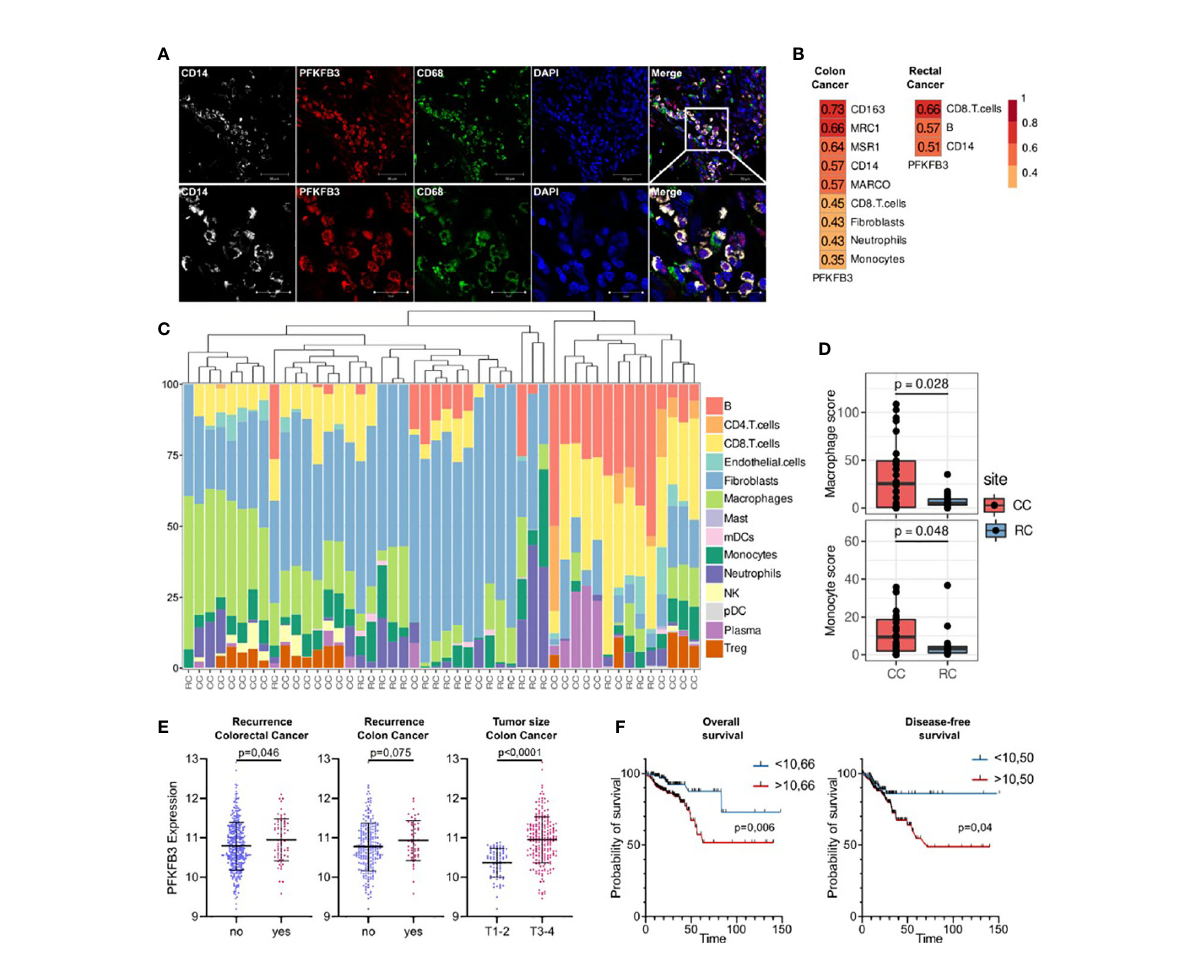
FIGURE 6 An activator of glycolysis PFKFB3 is overexpressed in colon cancer and is indicative for higher risk of tumor relapse in colon cancer but not rectal cancer. (A) , С olon cancer tissue is massively in fi ltrated by PFKFB3-positive monocytes. IF/confocal microscopy analysis was performed for 10 colon tumor tissues. The in fi ltration of CD14+CD68+PFKFB3+ cells was found in all samples. Representative image is given from one patient. Scale bar corresponds to 50 µm in main image and 20 µm in zoom image. (B) , Spearman correlation coef fi cients between PFKFB3 expression, M2 macrophage gene expressions and predicted cell abundance scores, FDR<0.05. (C) , Predicted cell composition of CD45+ AOIs and hierarchical clustering of AOIs. (D) , Difference in monocyte and macrophage cell abundance scores between the CD45+ AOIs in colon and rectal cancers (the Mann-Whitney U test was applied). (E) , PFKFB3 gene expression is elevated in patients with recurrence and larger tumor size in colon cancer. Variance in PFKFB3 expression was stabilized via the variance stabilizing transformation (VST). (F) , PFKFB3 had prognostic signi fi cance for the DFS and OS. High-risk group had worse survival rates compared to low-risk group. ROC analysis and Kaplan – Meier method were